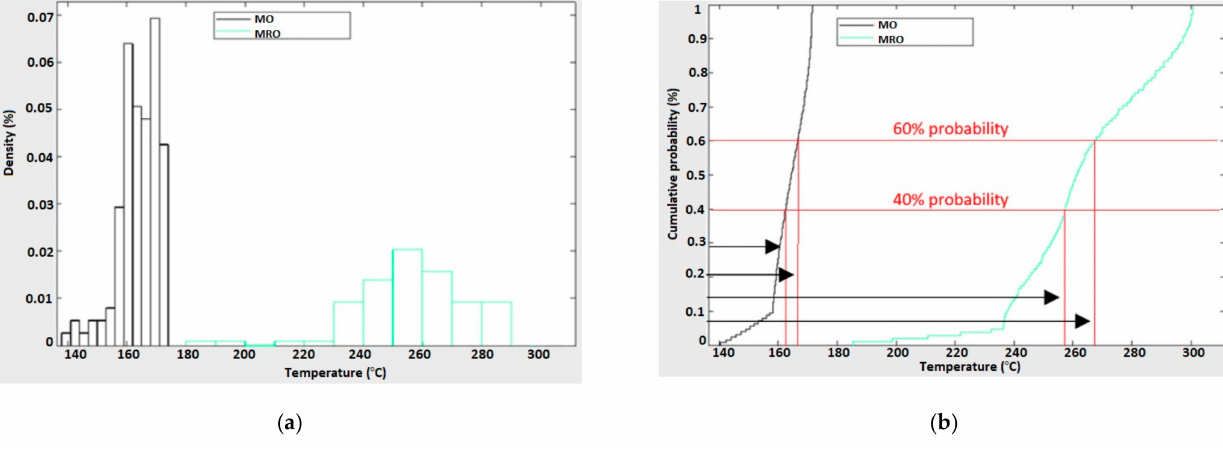
Figure 25. Flash point of MRO and MO with ( a ) survival, ( b ) hazard function with 95% confidence interval fitted to the